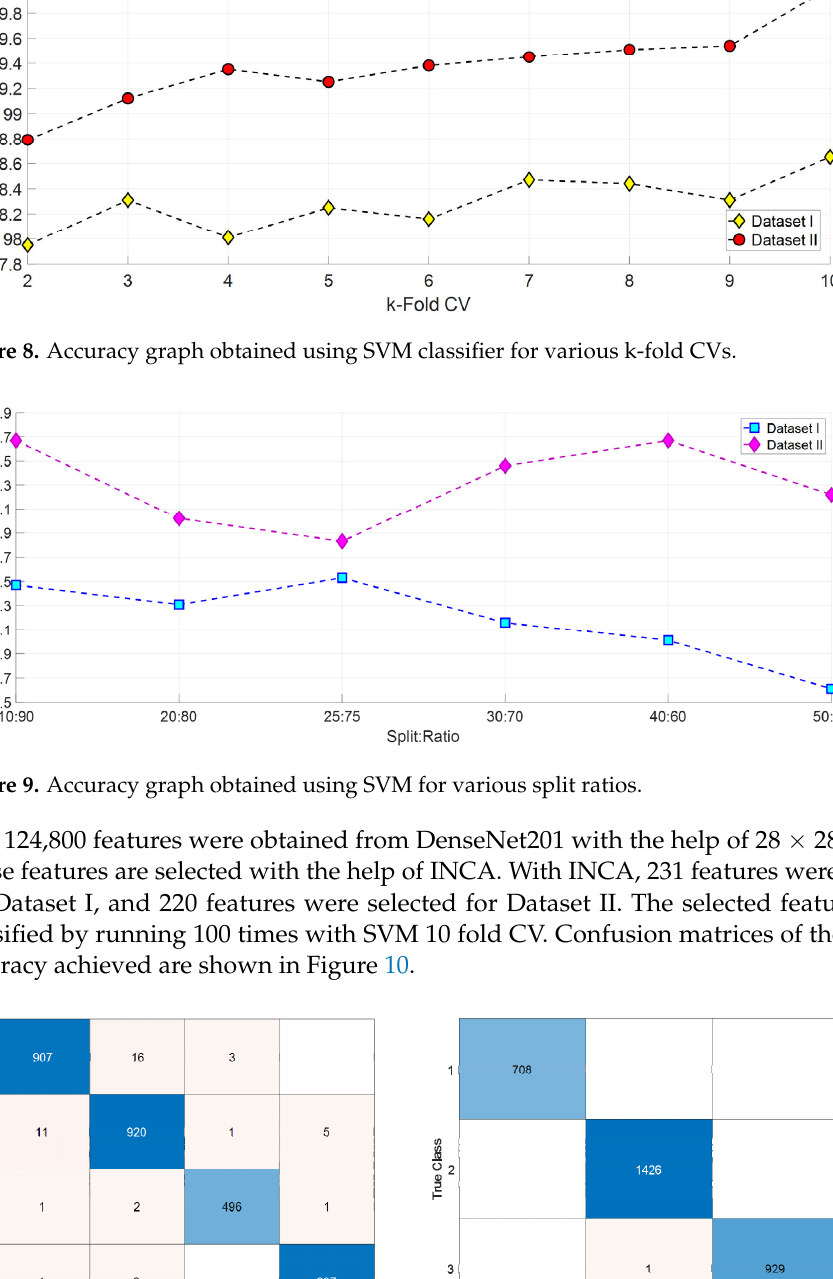
Figure 10. Confusion matrices obtained using SVM with 10-fold CV. Legend: ( a ) Dataset I 1 = Glioma Tumor, 2 = Meningioma Tumor, 3 = No Tumor, 4 = Pituitary Tumor, ( b ) Dataset II Legend 1 = Meningioma Tumor, 2 = Glioma Tumor, 3 = Pituitary